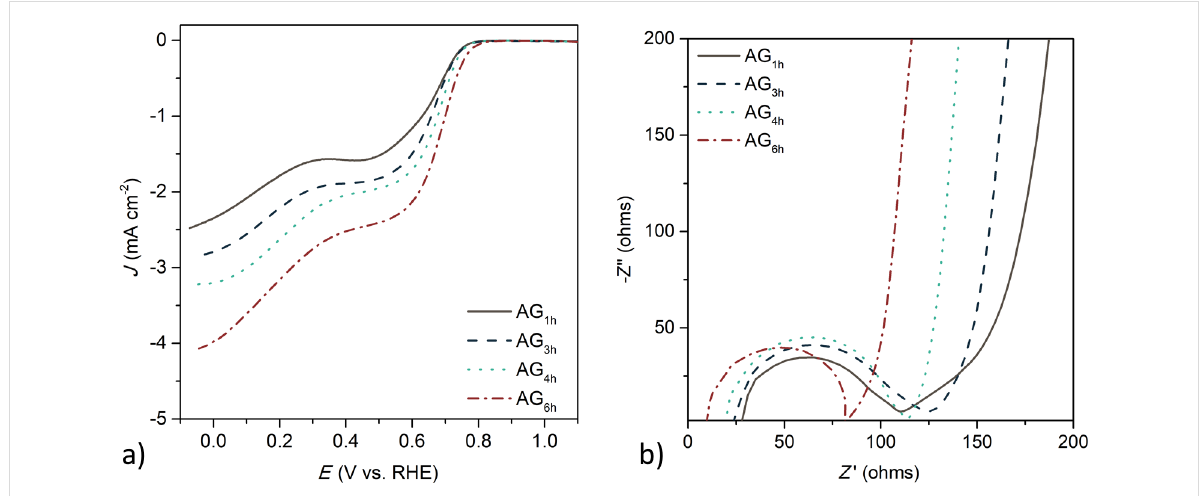
Figure 2: Linear sweep voltammetry recorded in an O 2 -saturated 0.1 mol L − 1 KOH electrolyte at 1600 rpm (a) and Nyquist plot obtained from electro- chemical impedance spectroscopy (b).